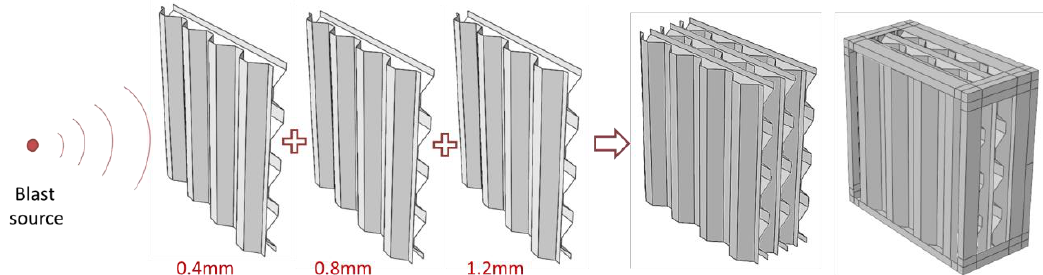
Figure 13. The composition of the graded trapezoidal core.